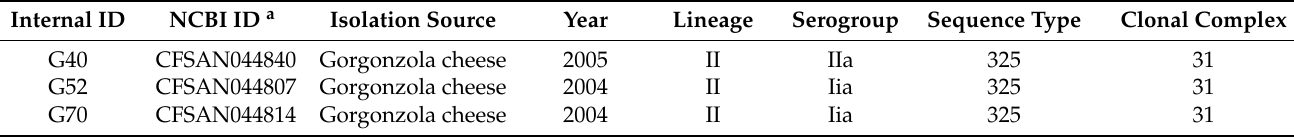
Table 1. Characteristics of L. monocytogenes strains used for challenge